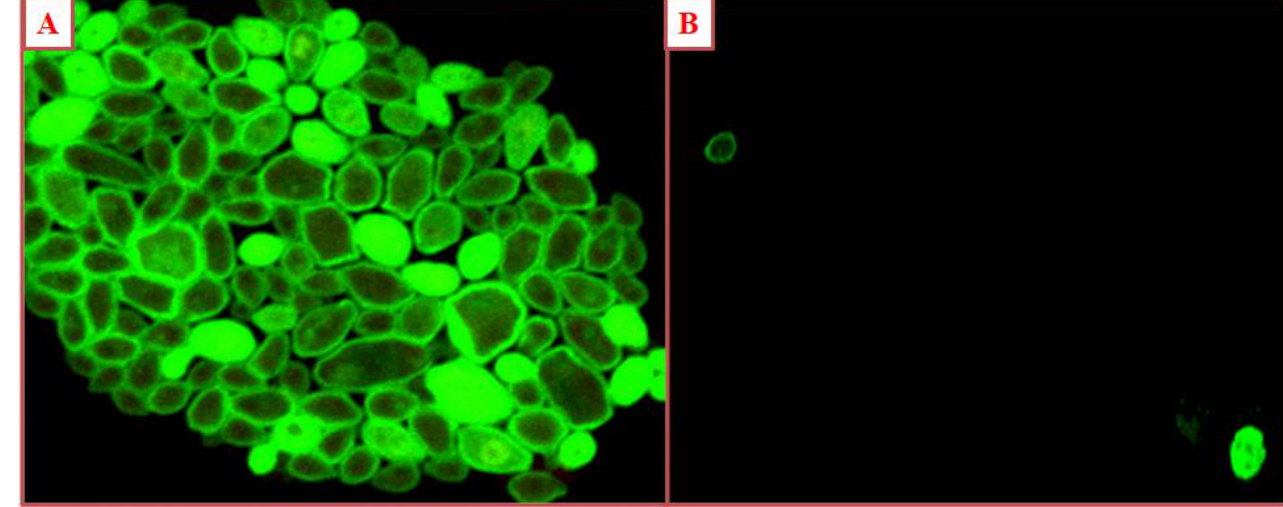
Figure 8. CLSM images of ( A ) C. albicans (Untreated); ( B ) 500 µg/mL of CS-AgNPs.